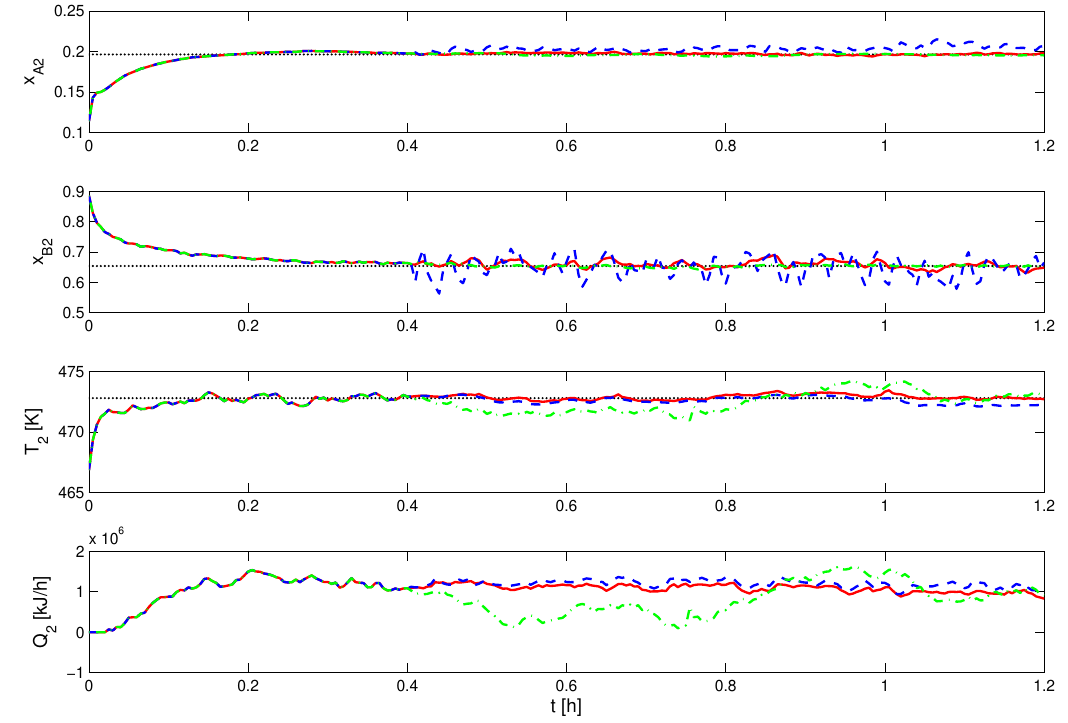
Figure 3. States and input trajectories of subsystem 2 given by the proposed distributed MHE-LMPC (solid line), scheme II (dash-dotted line) and scheme III (dashed line). The set points of states are denoted as dotted